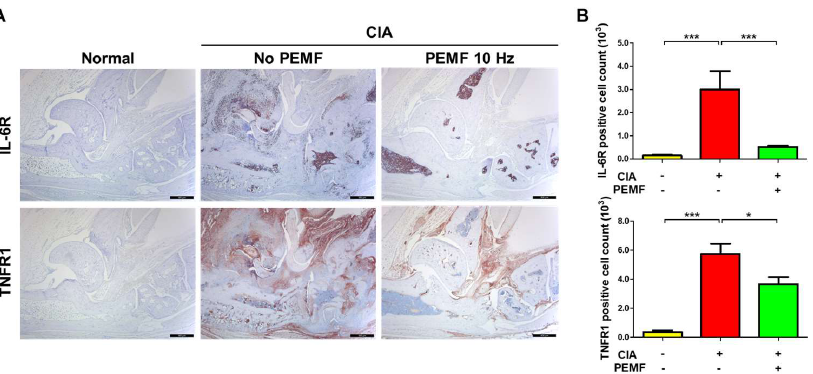
Figure 7. Effects of PEMF (10 Hz) on IL-6R and TNFR1 levels in ankle joint tissues. ( A ) Immuno- 500 µ m. ( B ) The percentage of IL-6R-positive and TNFR1-positive cells. Data are presented as the mean ± SEM. Normal, n = 7; CIA, n = 6; CIA+PEMF 10 Hz, n = 10. Significance was measured using a two-tailed Student’s t -test (* p < 0.05 and *** p <